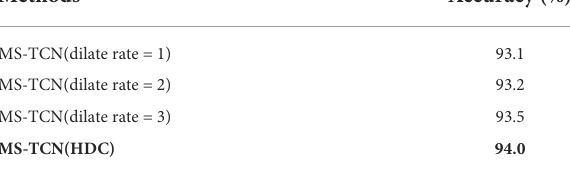
TABLE 5 Accuracy comparison of different dilated convolution rates used in temporal graph convolution layer on the Filtered NTU RGB+D dataset.